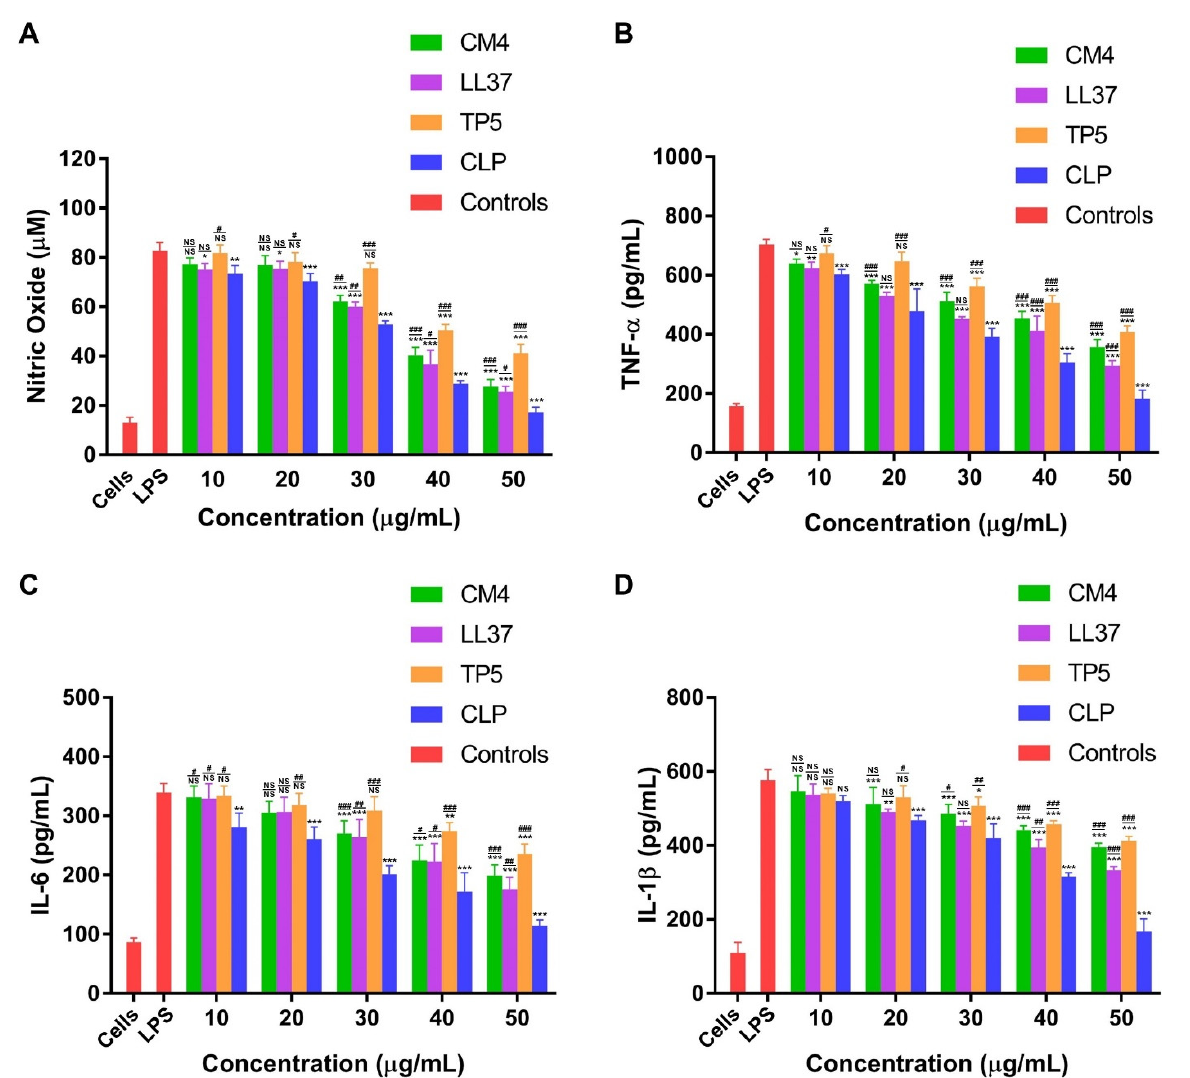
Figure 4. Effect of CLP and parent peptides (CM4, LL37, and TP5) on LPS-stimulated pro-inflammatory cytokine secretion in mouse RAW264.7 macrophages. ( A ) The levels of NO. ( B ) The levels of TNF- α . ( C ) The levels of IL-6. ( D ) The levels of IL-1 β . Inflammatory production of cells was induced with LPS and attenuated by treatment with various concentrations of CLP and parent peptides (CM4, LL37, and TP5). The supernatant was collected after 24 h of incubation and the levels of inflammatory cytokines were determined. NS, * p < 0.05, ** p < 0.01, and *** p < 0.001 represented a comparison of the hybrid peptide CLP and parent peptides vs. LPS. NS, # p < 0.05, ## p < 0.01, and ### p < 0.001 indicated a comparison of the parent peptides vs. CLP.